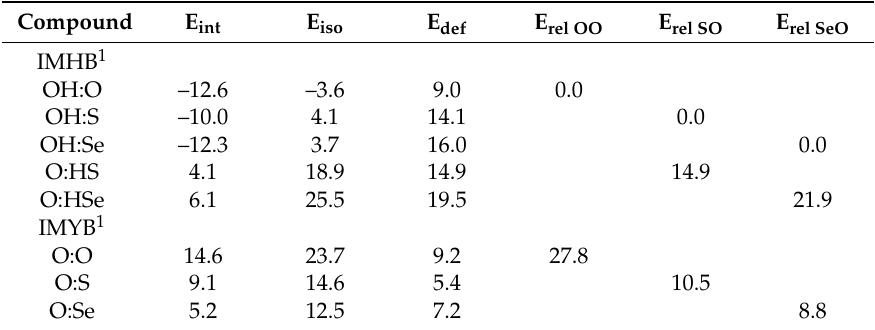
Table 2. Relative energies, E rel , and interaction energies, E iso , E int , and deformation energies E def , (kJ · mol − 1 ) for the different compounds at MP2/CBS computational